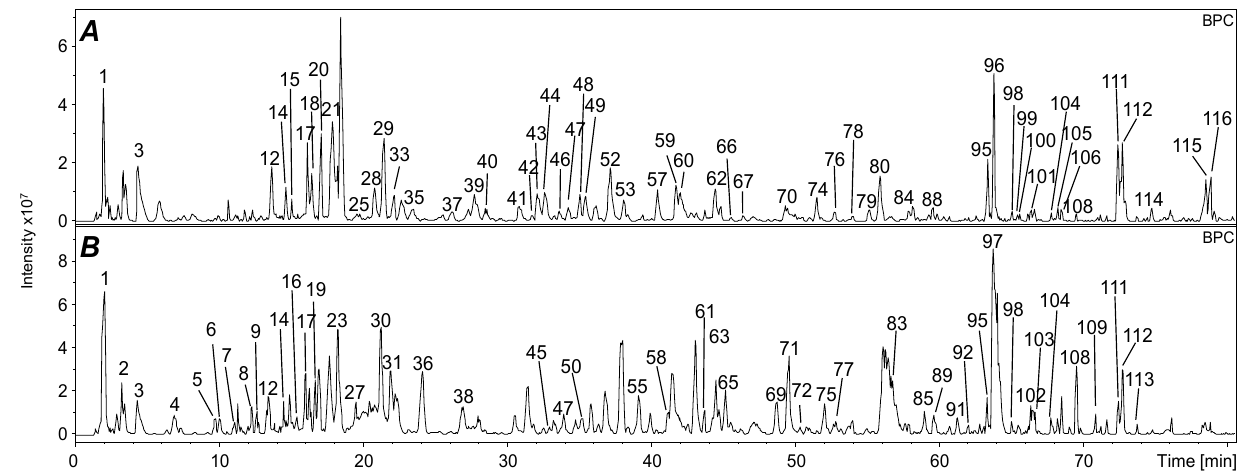
Figure 3. LC/MS n chromatograms (BPC) of phenolic compounds in MeOH seed extracts of Geum urbanum ( A ) and Geum rivale ( B ). For compound assignment, see Table 1. For the sake of clarity, not all assigned compounds are numbered. According to the retention times shown in Table 1, the corresponding peaks could be assigned.